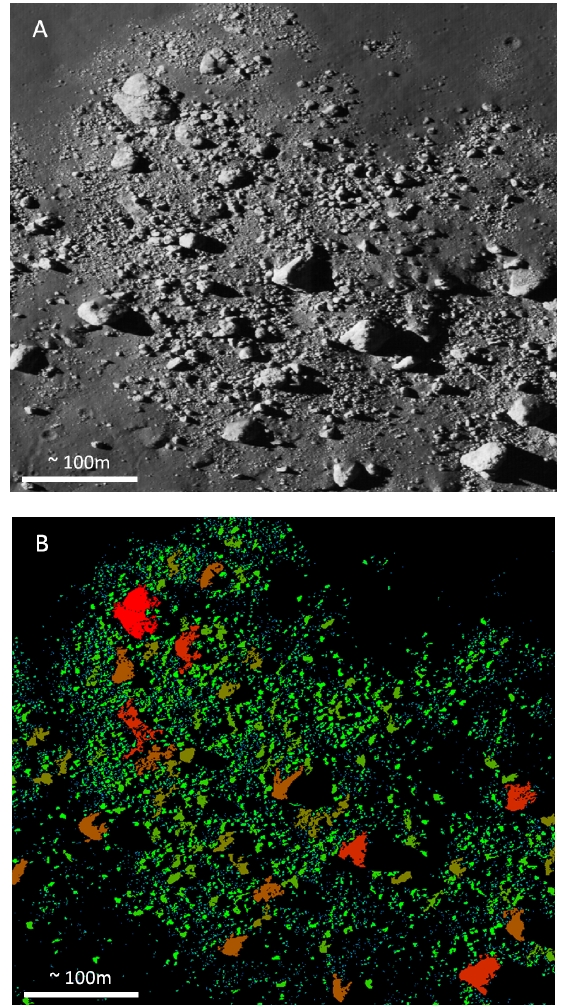
Figure 1. (A) Subset of NAC image M135433752LE covering a boulder field situated around -30.4°lat and 322.5°lon (B) Groups of pixels detected as bright faces of boulders on the image (colors correspond to ranges of